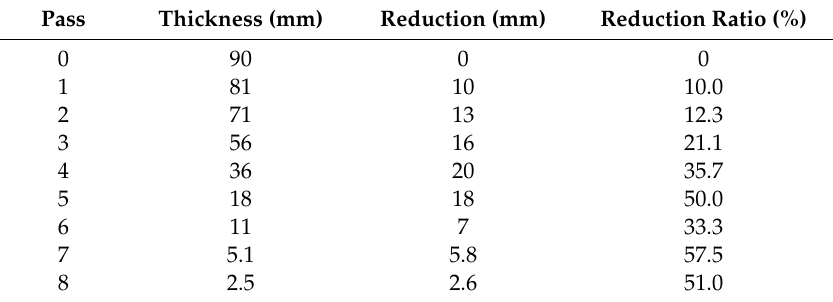
Table 2. The reduction of each pass during hot